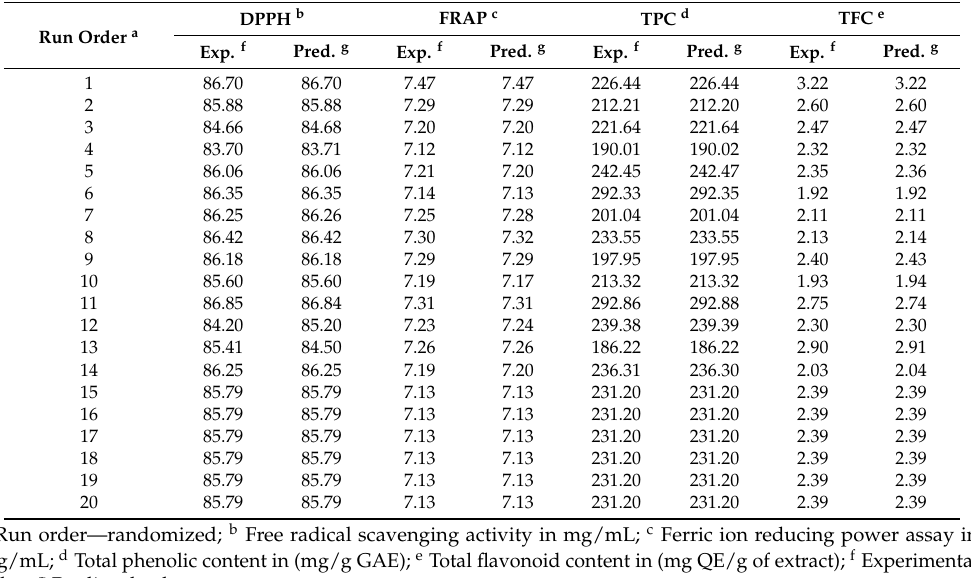
Table 1. The experimental and predicted values for the responses of DPPH, FRAP, TPC and TFC under different